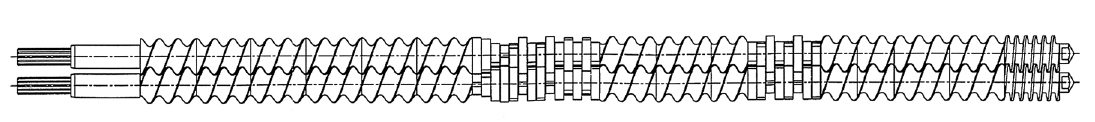
Figure 2. Employed twin screw